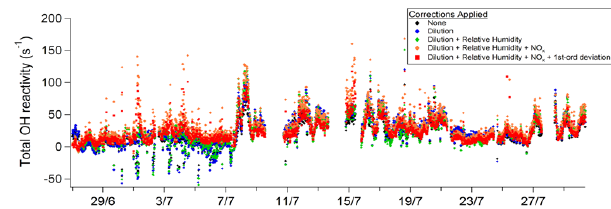
Figure 11. Time series of ambient OH reactivity measurements for the Dunkirk field campaign, including (1) uncorrected mea- surements (black symbols), (2) measurements corrected for dilu- tion (blue symbols), (3) previous + measurements corrected for dif- ferences in relative humidity between C2 and C3 (green symbols), (4) previous + measurements corrected for the NO and NO 2 arti- facts (orange symbols), and (5) previous + measurements corrected for not operating the instrument under pseudo-first-order conditions (red symbols). These data are